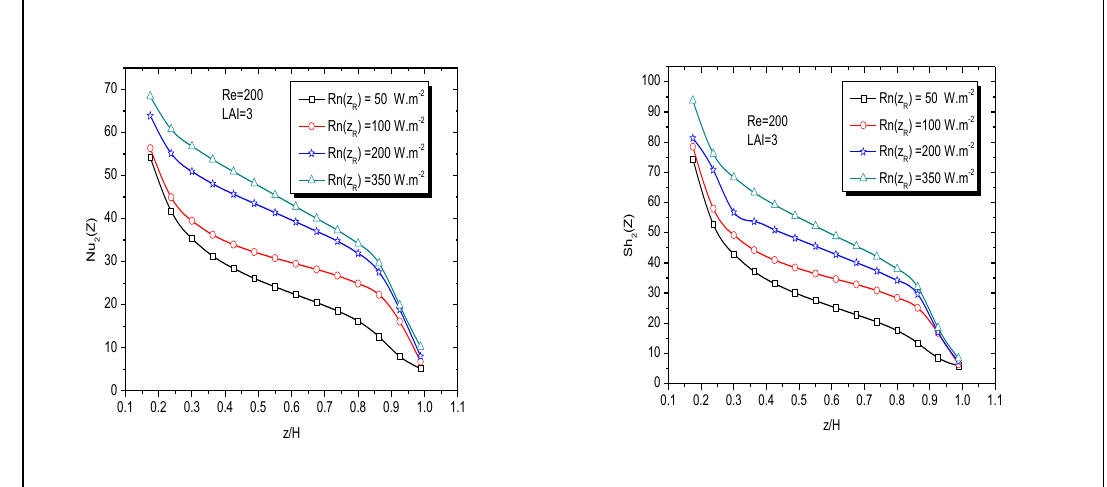
Figure 7 . Influence of solar flux density on the variation of local Nusselt and Sherwood numbers for wetted wall